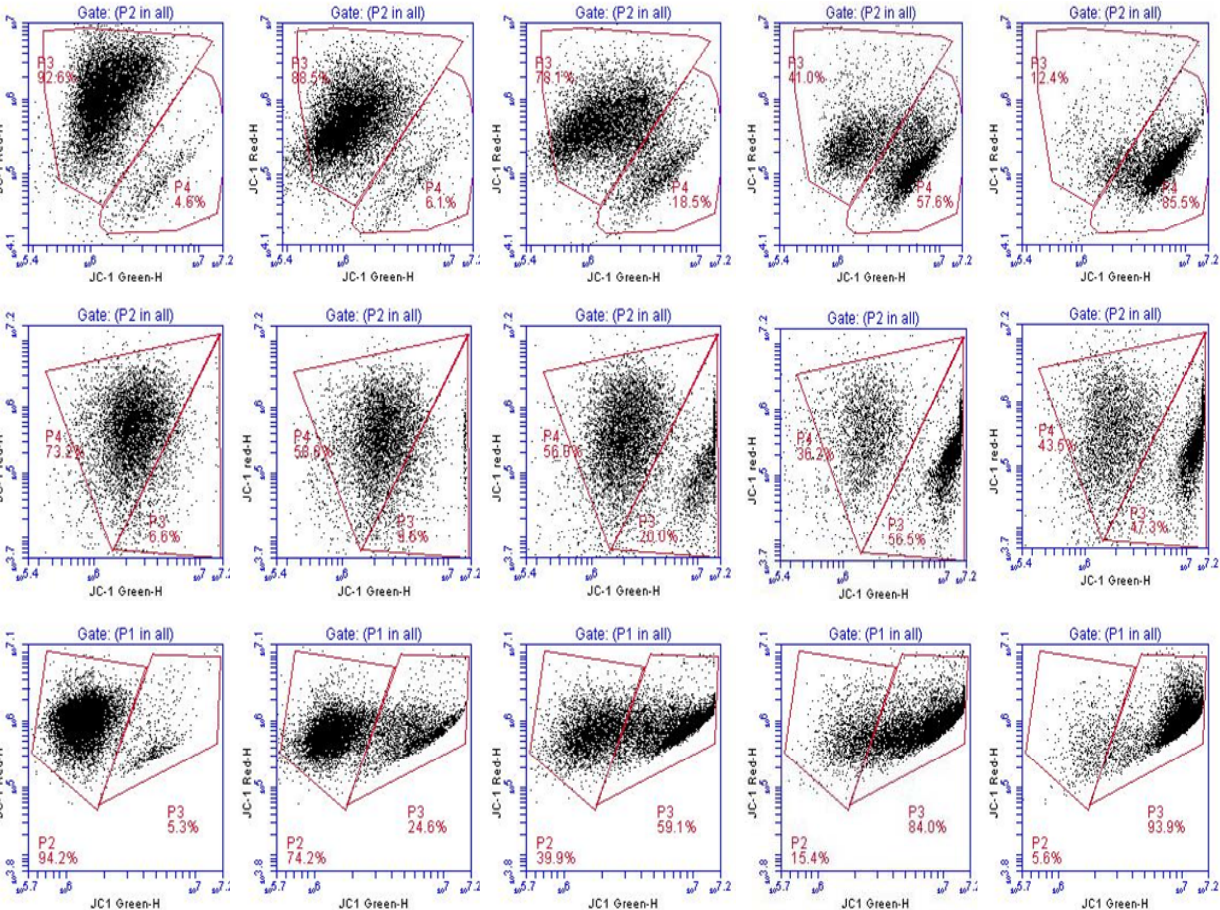
Figure S2 . FACS analysis of pancreatic cancer cells loaded with mitochondrial membrane potential probe